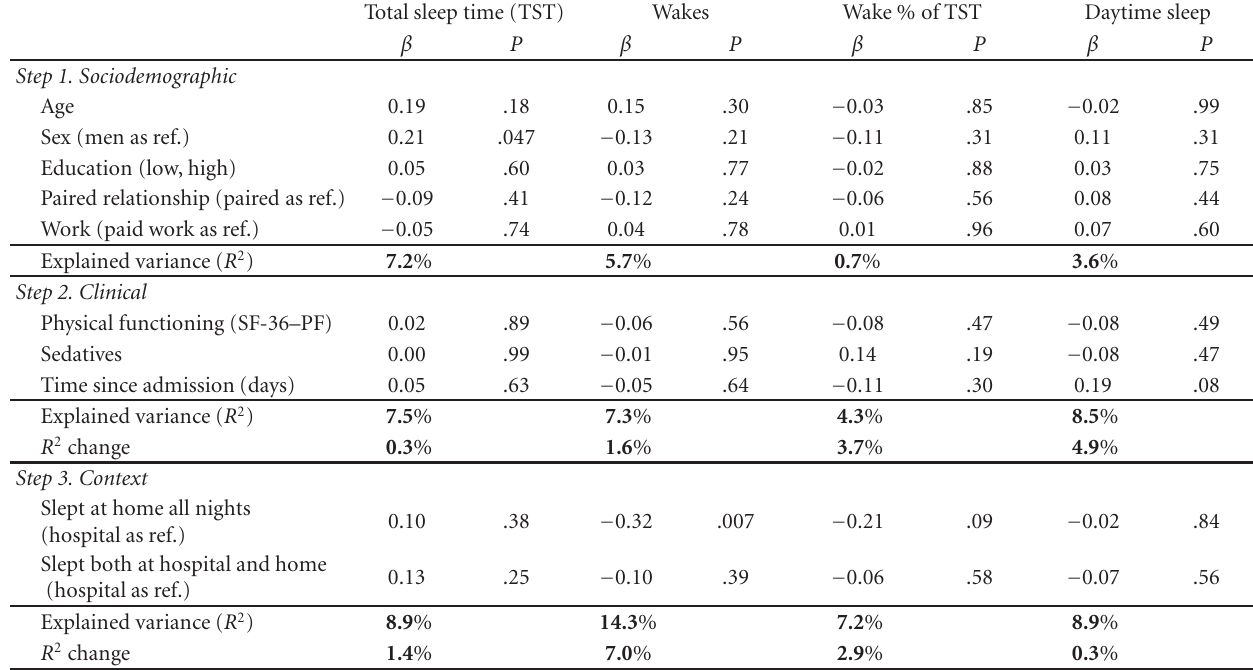
Table 5: Multivariate analysis (linear regression) of the possible predictors (sociodemographic, clinical variables and context) of sleep-wake patterns with total sleep time, number of wakes, wake in percent, and minutes sleep at daytime as dependent variables (standardized beta, N =